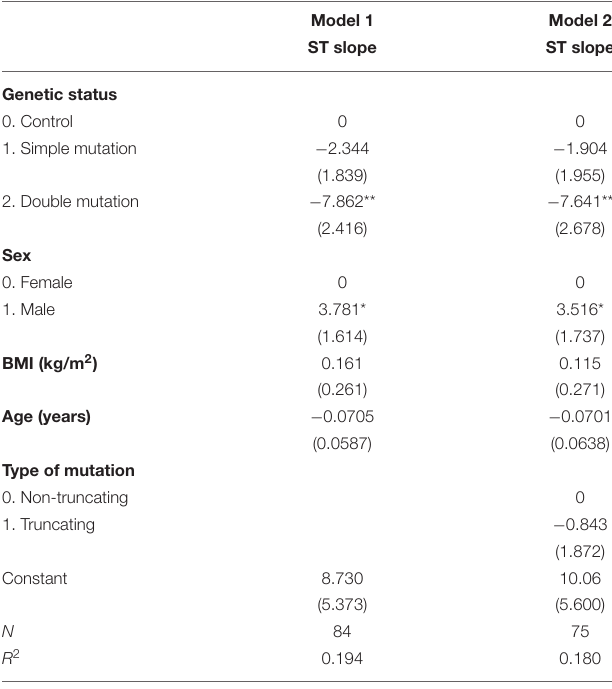
TABLE 4 | Linear regression